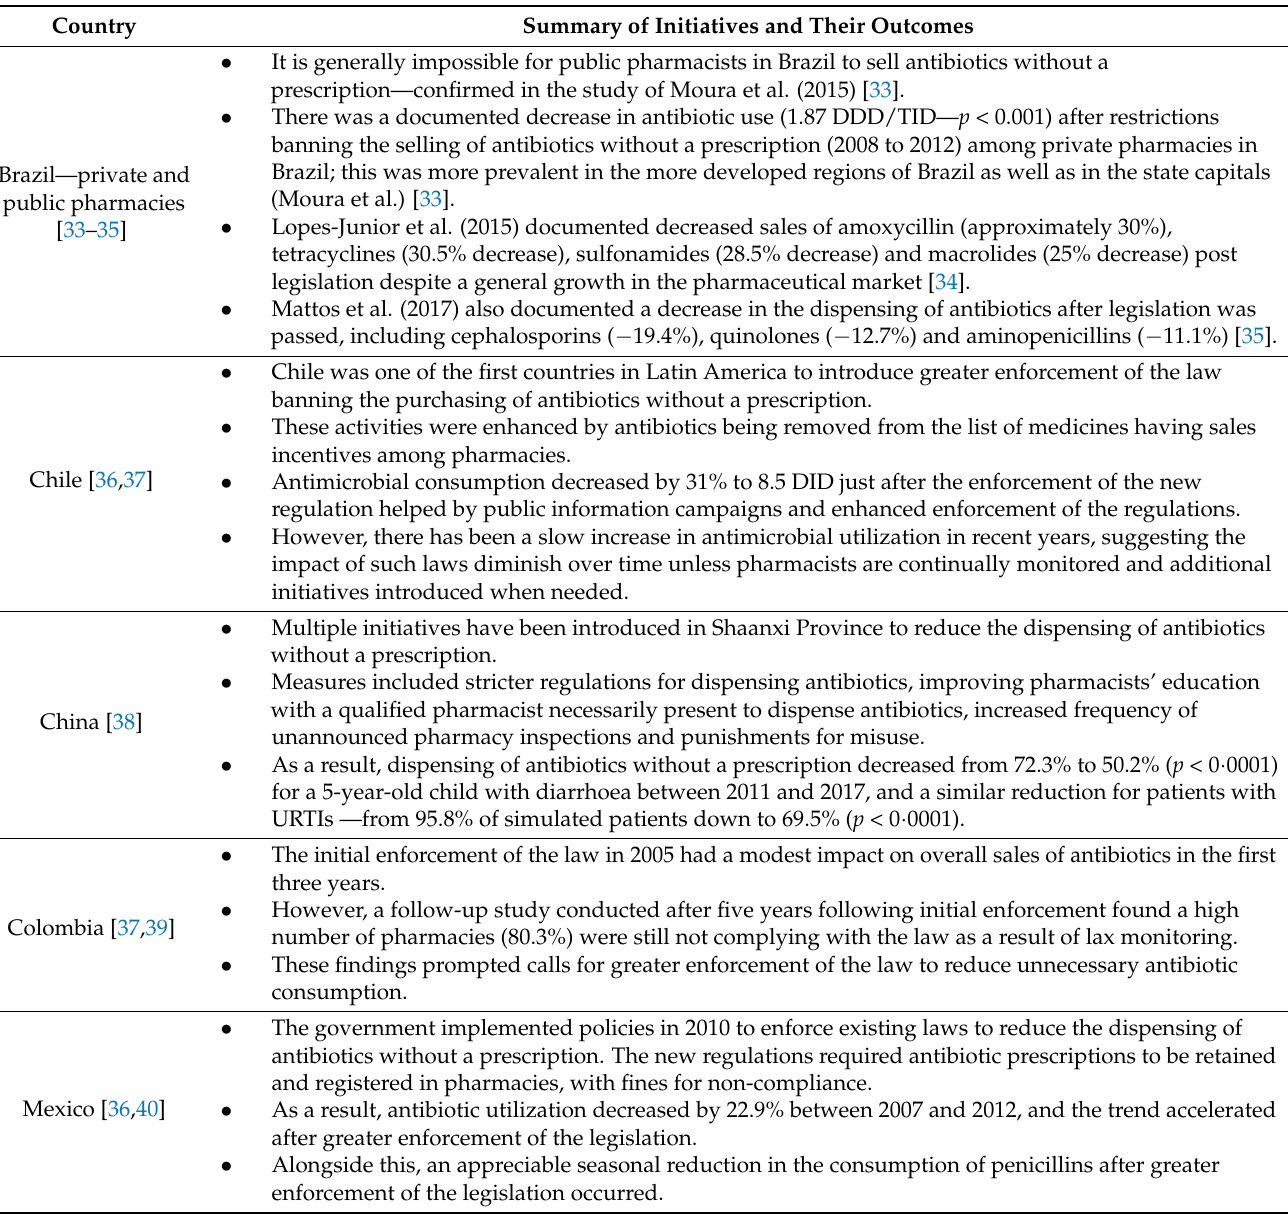
Table 1. Summary of laws and activities especially among low- and middle-income countries banning the purchasing of antibiotics without a prescription and their